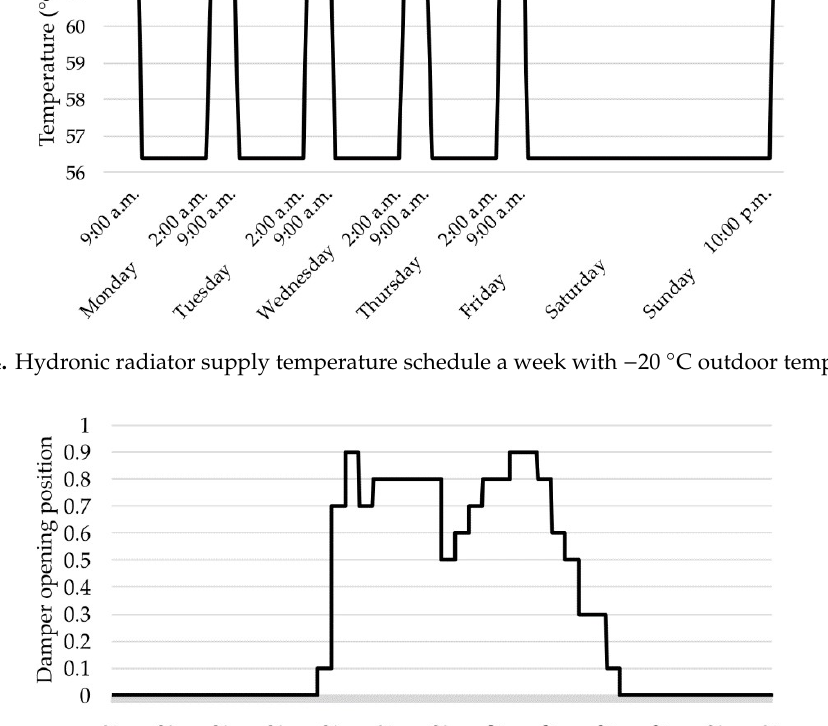
Figure 3. Linear correlation of rotary heat exchanger temperature efficiency in AHU and outdoor temperature; data set 1 September 2014 until 31 May 2015 (sampled every 10 min).